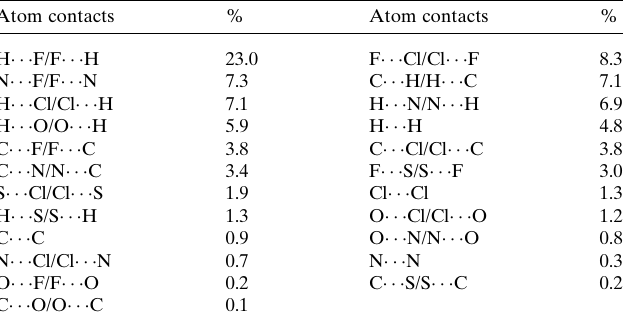
Table 3 Some structures similar to I deposited in the